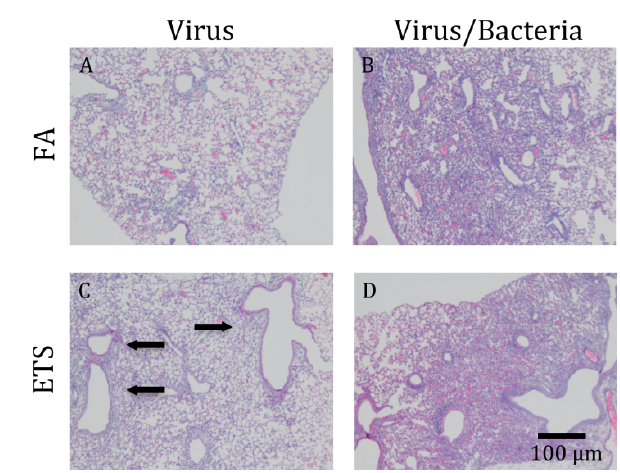
Figure 6. Lung pathology. Hemotoxylin and eosin staining was done on fixed right lung tissue. All lobes were stained. Images presented here photographed at 5×. ( A ) Virus+FA causes patches of mild inflammation, mostly found in the alveoli. ( C ) Virus + ETS caused increased inflammation around the bronchioles (arrows), as compared to virus + FA. ( B ) and ( D ) show that a secondary bacterial infection causes a greater influx of cells to become localized around the airways and throughout the